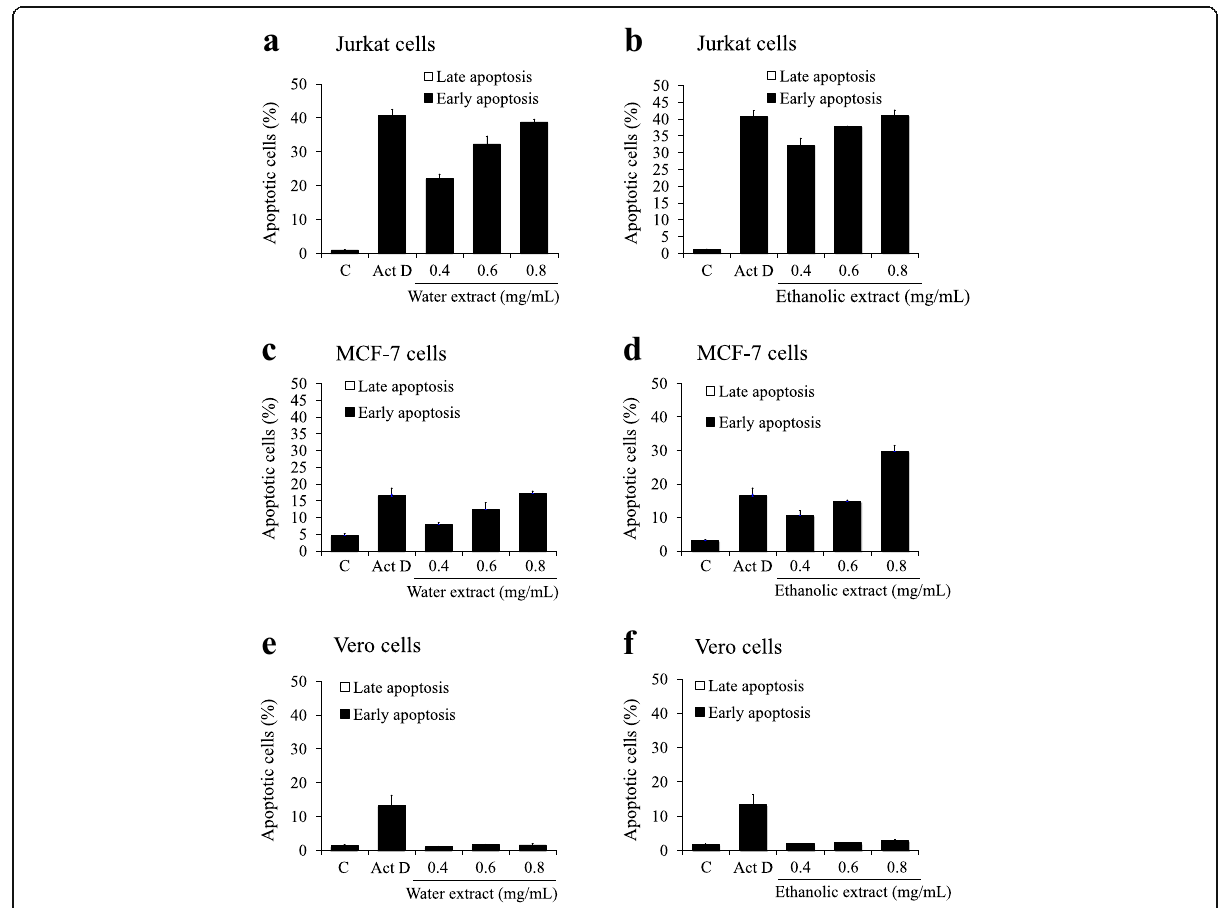
Fig. 4 Flow cytometric analysis of apoptosis induction in Jurkat ( a , b ), MCF7 ( c , d ) and Vero ( e , f ) cells. Cells were treated with various concentrations of water and ethanolic extracts prepared from the powdered formula of H. cordata fermented broth and P. emblica fruit for 24 h. The Annexin V-FITC/PI staining apoptotic cells were analyzed using flow cytometry. Actinomycin D (Act D; 10 μ g/mL) was used as a positive control. Bar graph shows the summarized data from three independent experiments performed in duplicate compared with untreated control ( c